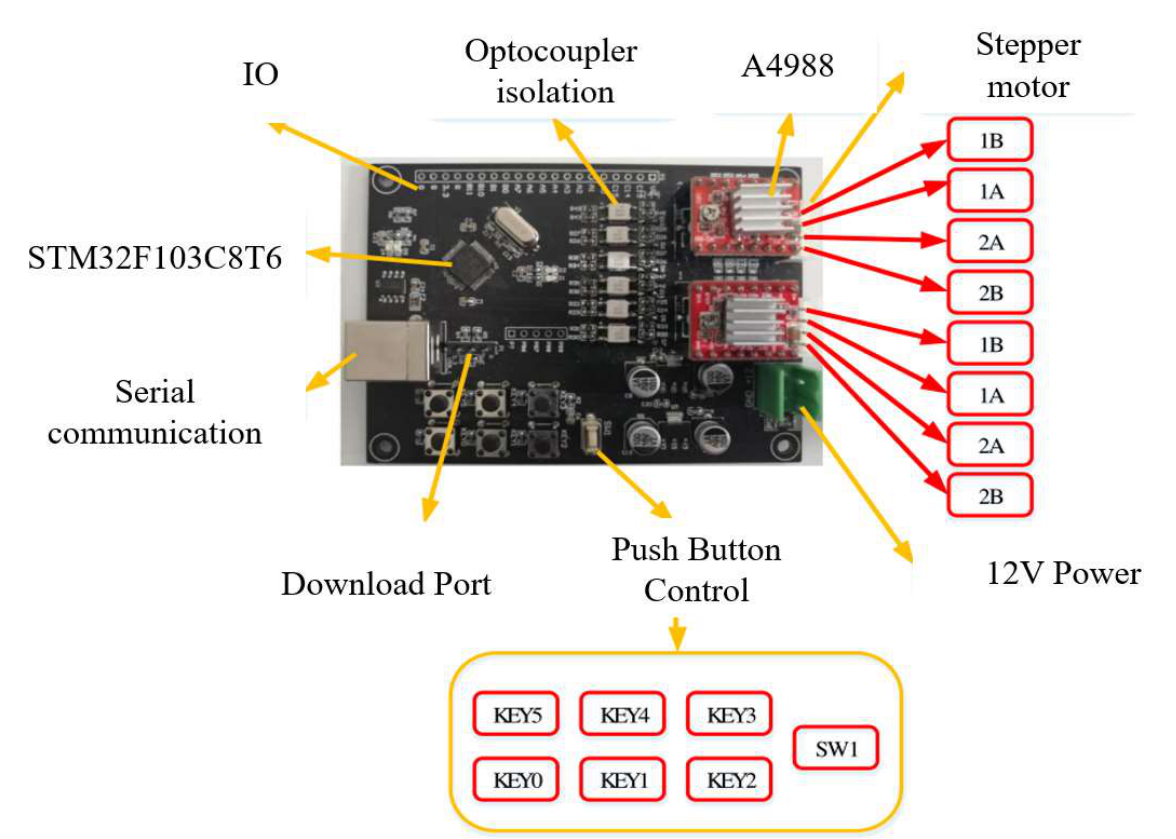
Figure 5. Schematic diagram of the control system structure.